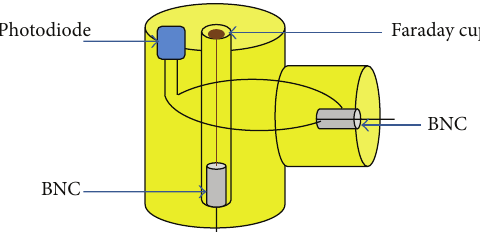
Figure 3: Schematic of arrangement of Faraday cup with photodi-